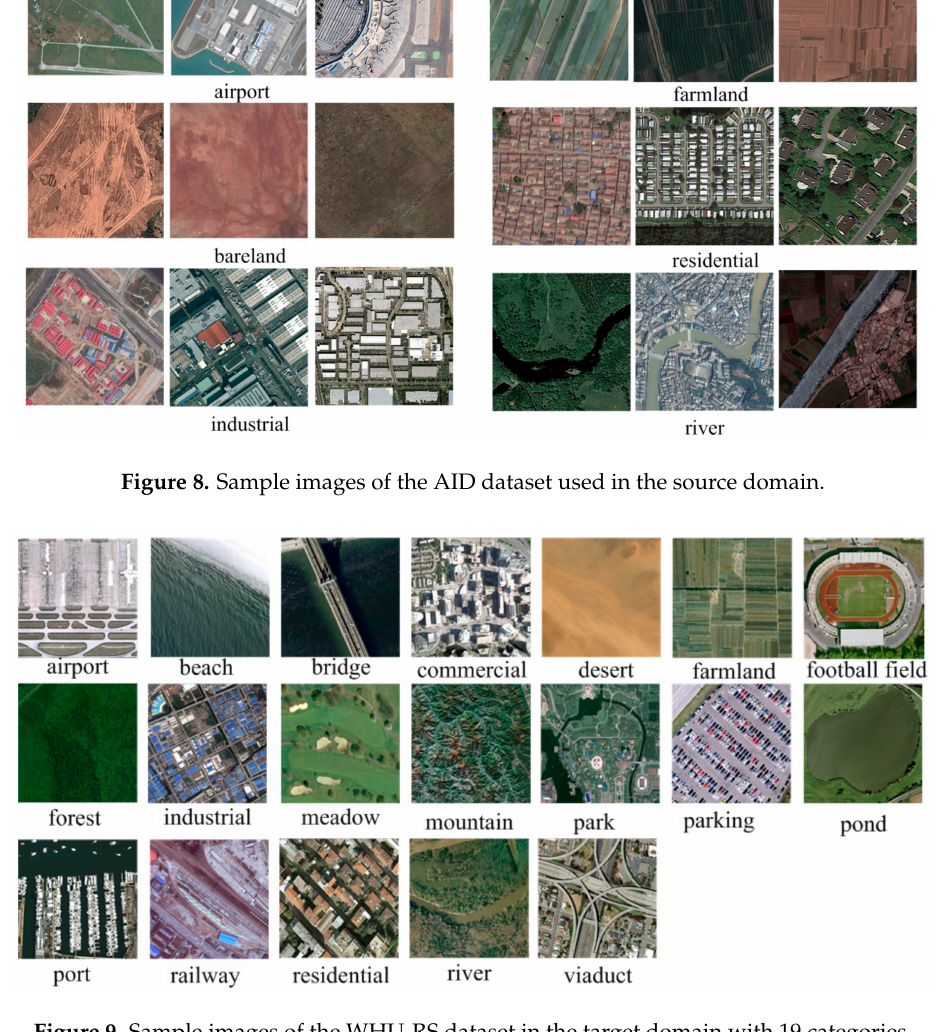
Figure 9. Sample images of the WHU-RS dataset in the target domain with 19